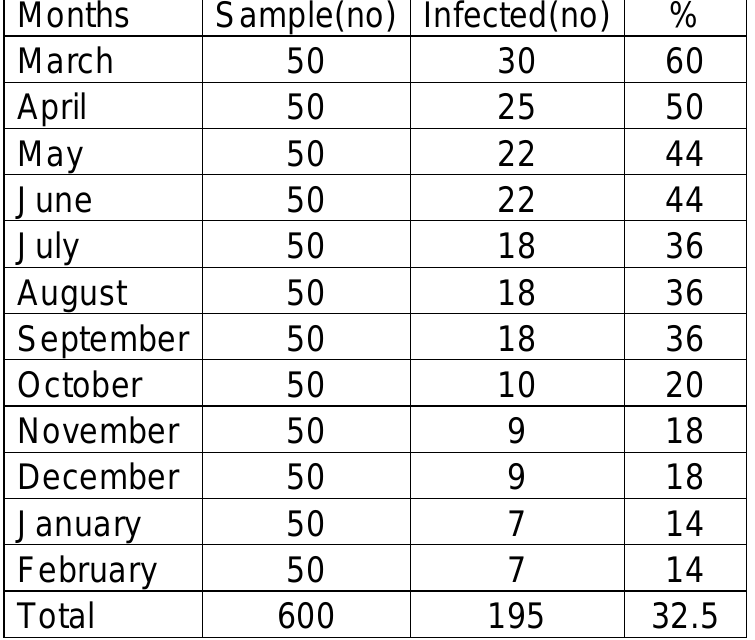
Table (1): Infection rates of E. histolytica during Months of the year Months